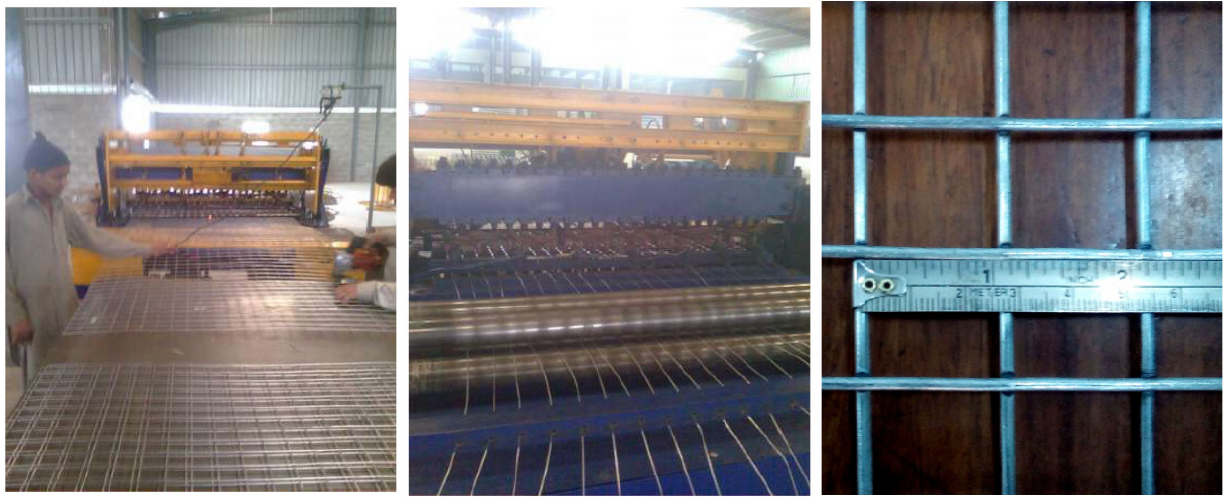
Figure 3. Preparation of spot-welded meshes. Table 4. Properties of steel wire mesh.